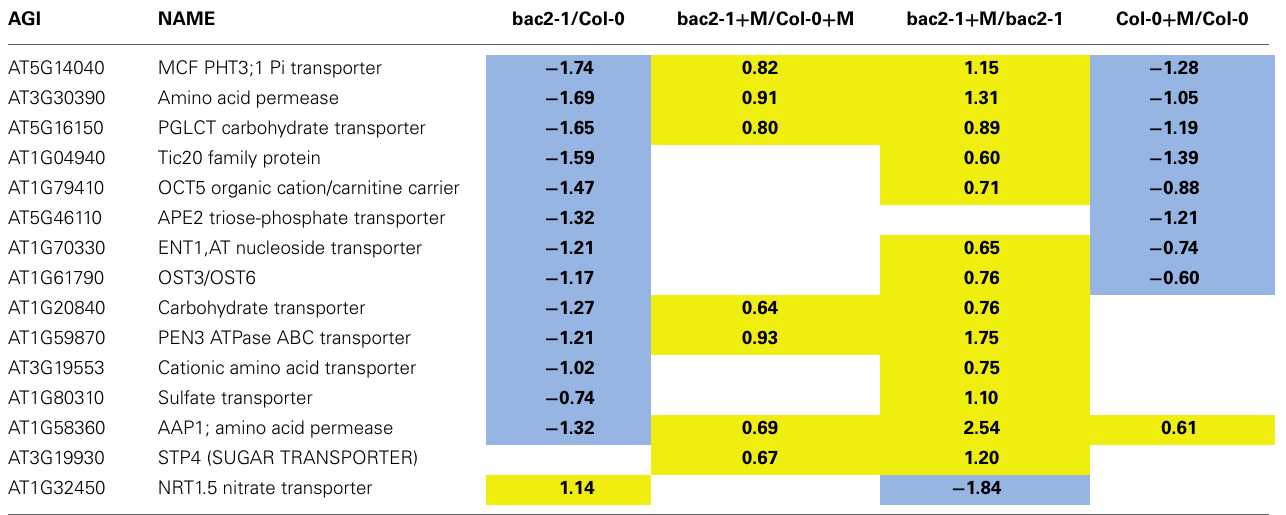
Table 3 | Carrier genes differentially expressed in bac2-1 .